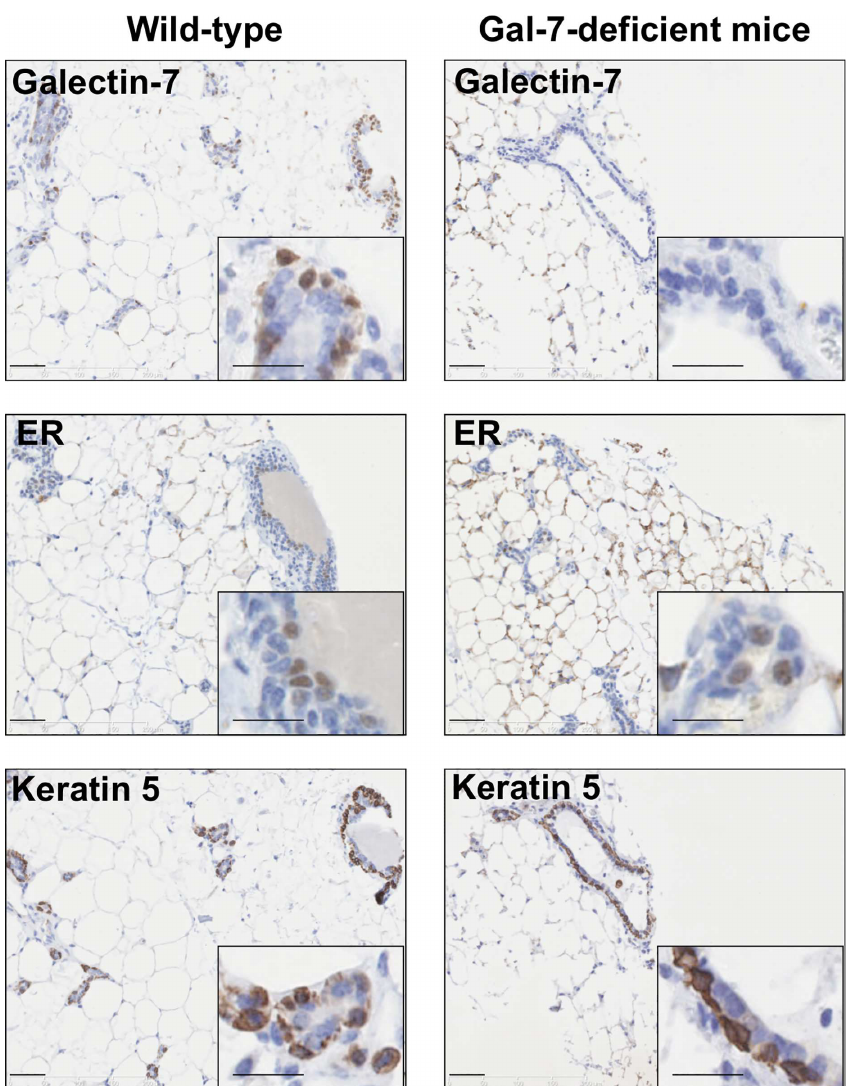
Fig 2. Expression of mammaryepithelial markersin wild-type and galectin-7-deficient mice. Immunohistochemicaldetectionof gal-7, estrogenreceptor (ER; mammary luminalepithelial cell marker) and cytokeratin 5 (CK5; mammary myoepithelial cell marker) on normalmammary tissues of wild-typeand galectin-7-deficientmice. Scale bars, 50 μ m and 25 μ m (insets).